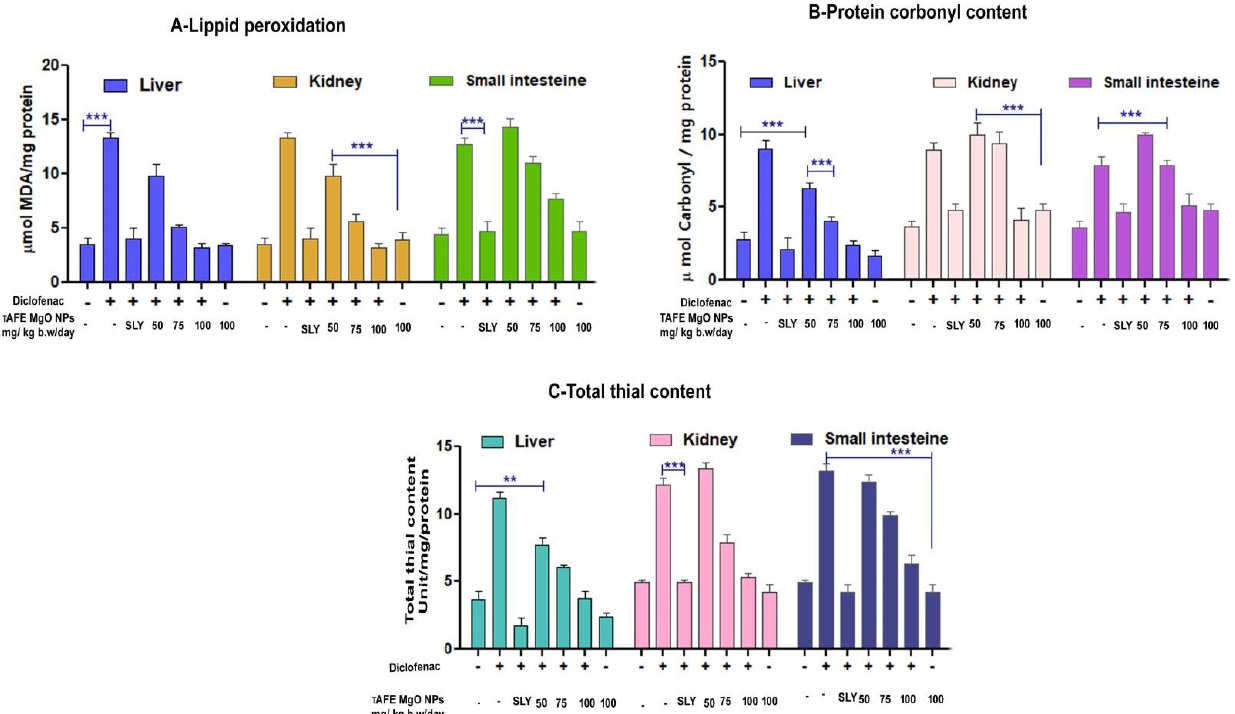
Figure 5. Effect of TAFEMgO NPs on oxidative stress induced by diclofenac in small intestines, kidneys, and livers: ( A ) lipid peroxidation, ( B ) protein carbonyls ( C ) total thiols and control, diclofenac (50 mg/kg), SLY + diclofenac (25 mg/kg), TAFEMgO NPs (50 mg/kg) + diclofenac, TAFEMgO NPs (75 mg/kg) + diclofenac, TAFEMgO NPs (100 mg/kg) + diclofenac, and TAFEMgO NPs alone (100 mg/kg) in comparison to the toxicity for control group. All samples presented were administered as mg/kg bodyweight/day. The data were represented as mean ( n = 3) ± SEM. ** Significance at p ≤ 0.001 and *** at p ≤